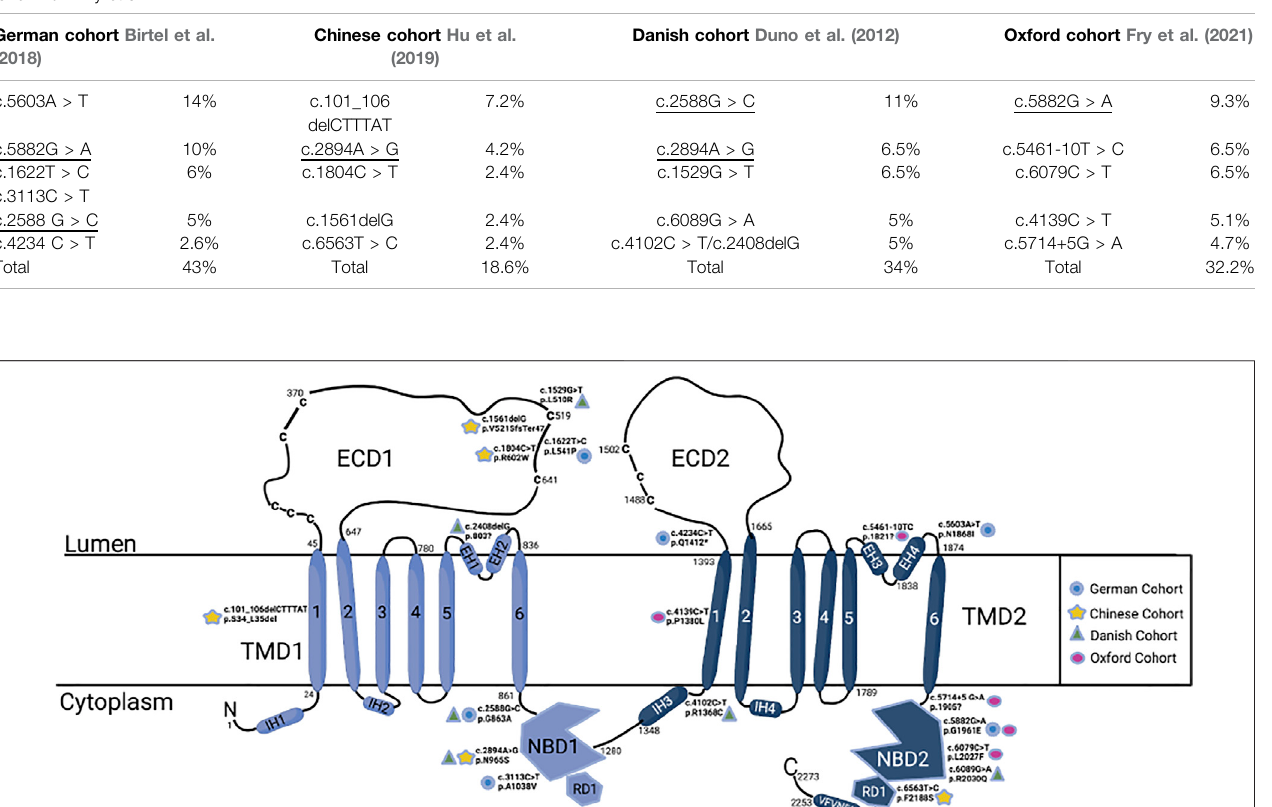
FIGURE5| ABCA4molecularstructure(Liuetal.,2021a)withthe fi vemostmutationsfromeachcohort.Thereare3 – 4notablehotspots:ECD1,NBD1,pre-TMD2, and NBD2. ECD, extracellular domain; NBD, nuclear binding domain; TMD, transmembrane domain. Blue circle- German cohort, yellow star- Chinese cohort, green triangle- Danish cohort, pink circle- Oxford cohort. Created with